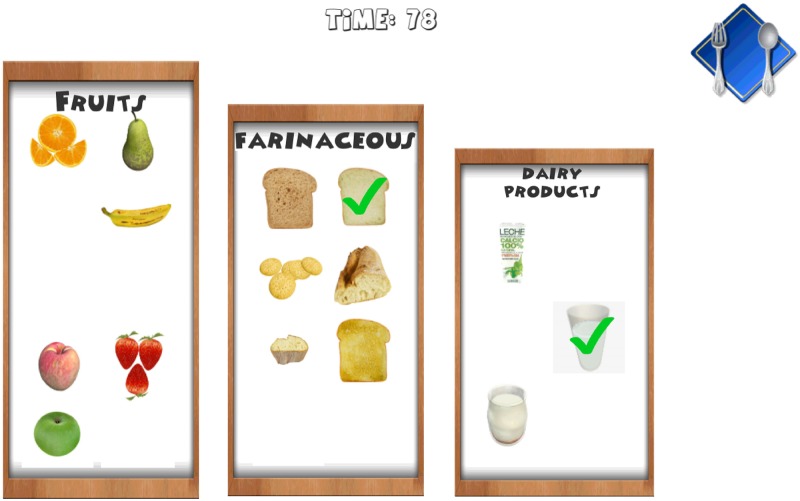
The final challenge.